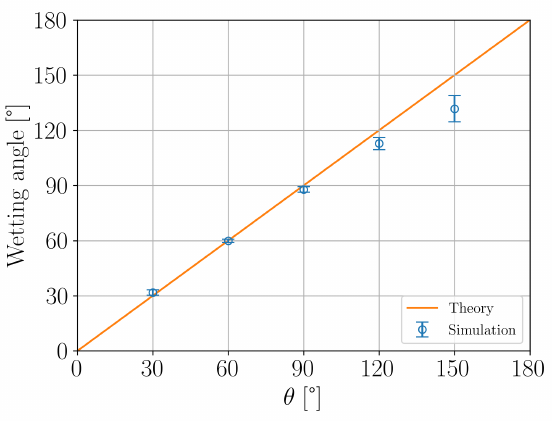
Figure 12. Comparison of simulation results and theory for the wetting of a vertical plate.